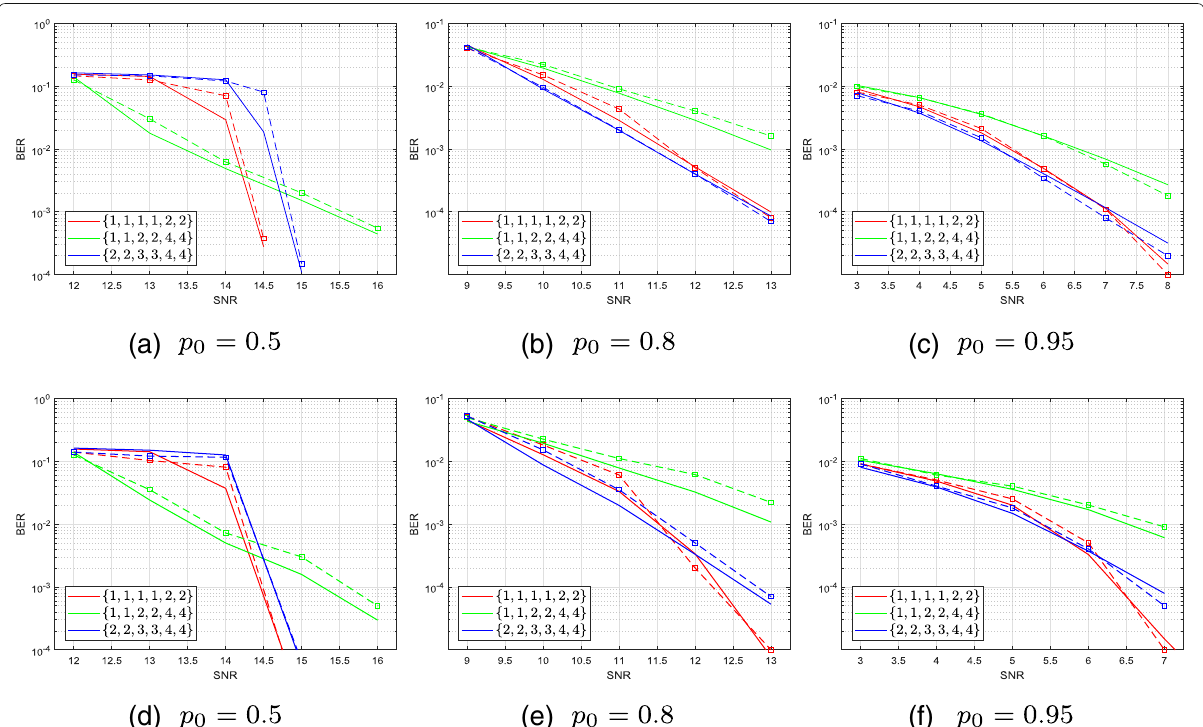
Fig. 7 Predicted (dashed line) and Monte Carlo simulated (continuous line) BER vs SNR curves for the RCM-LDGM codes. a – c The configuration with = 1. d – f The configuration with d ( v ) = 2. An AWGN channel is considered d ( v ) LDGM LDGM